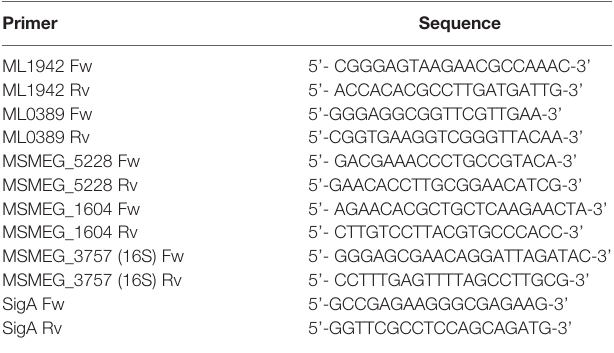
TABLE 2 | M. leprae and M. smegmatis qRT-PCR primer sequences.